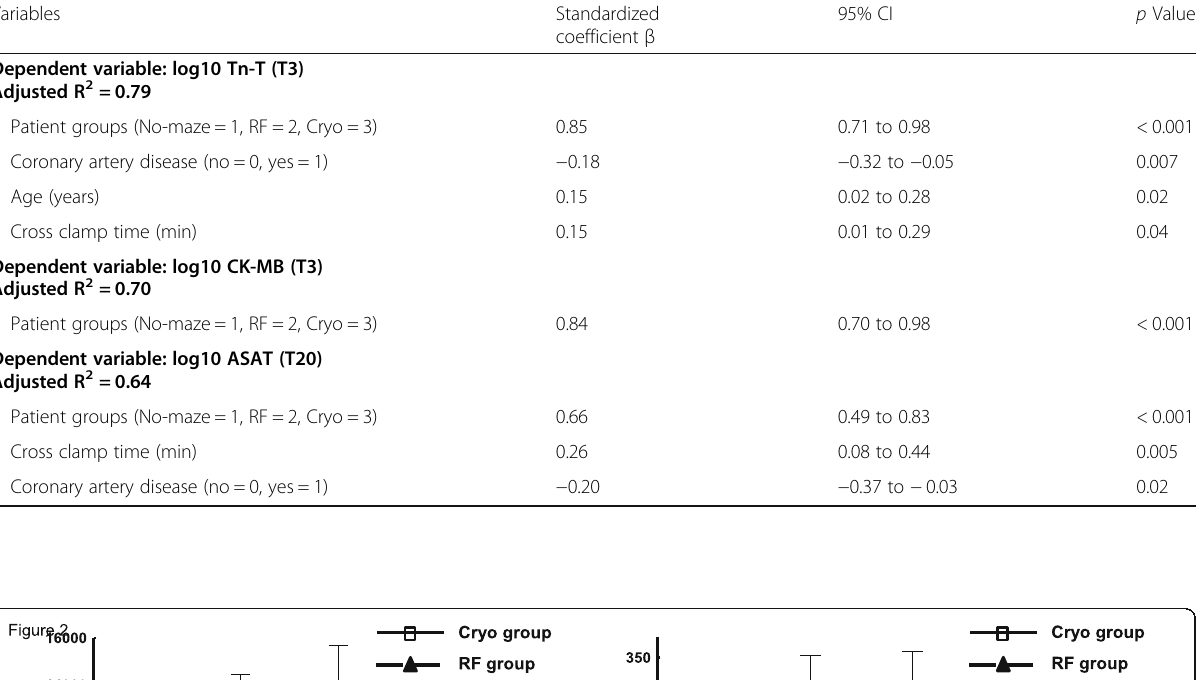
Table 4 Multivariable linear regression models to find factors influencing myocardial injury